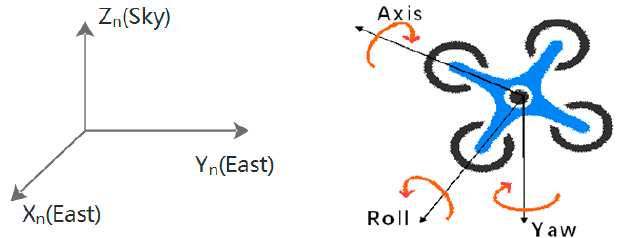
Figure 4. Navigation coordinate ( left ) and body coordinate ( right ) systems.